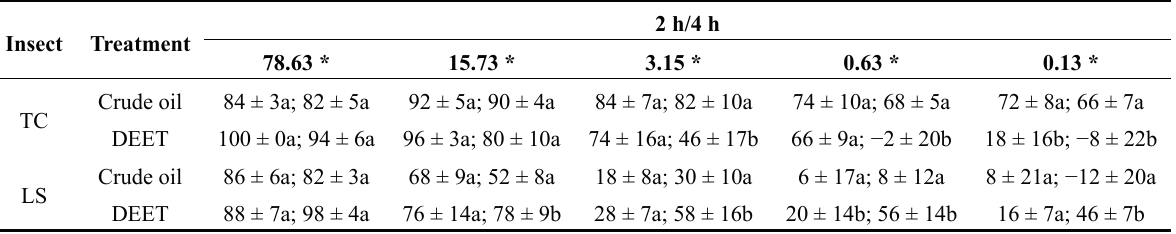
Table 3. Pecentage repellency (PR) after two exposure times for the essential oil against Tribolium castaneum (TC) and Lasioderma serricorne (LS) adults a